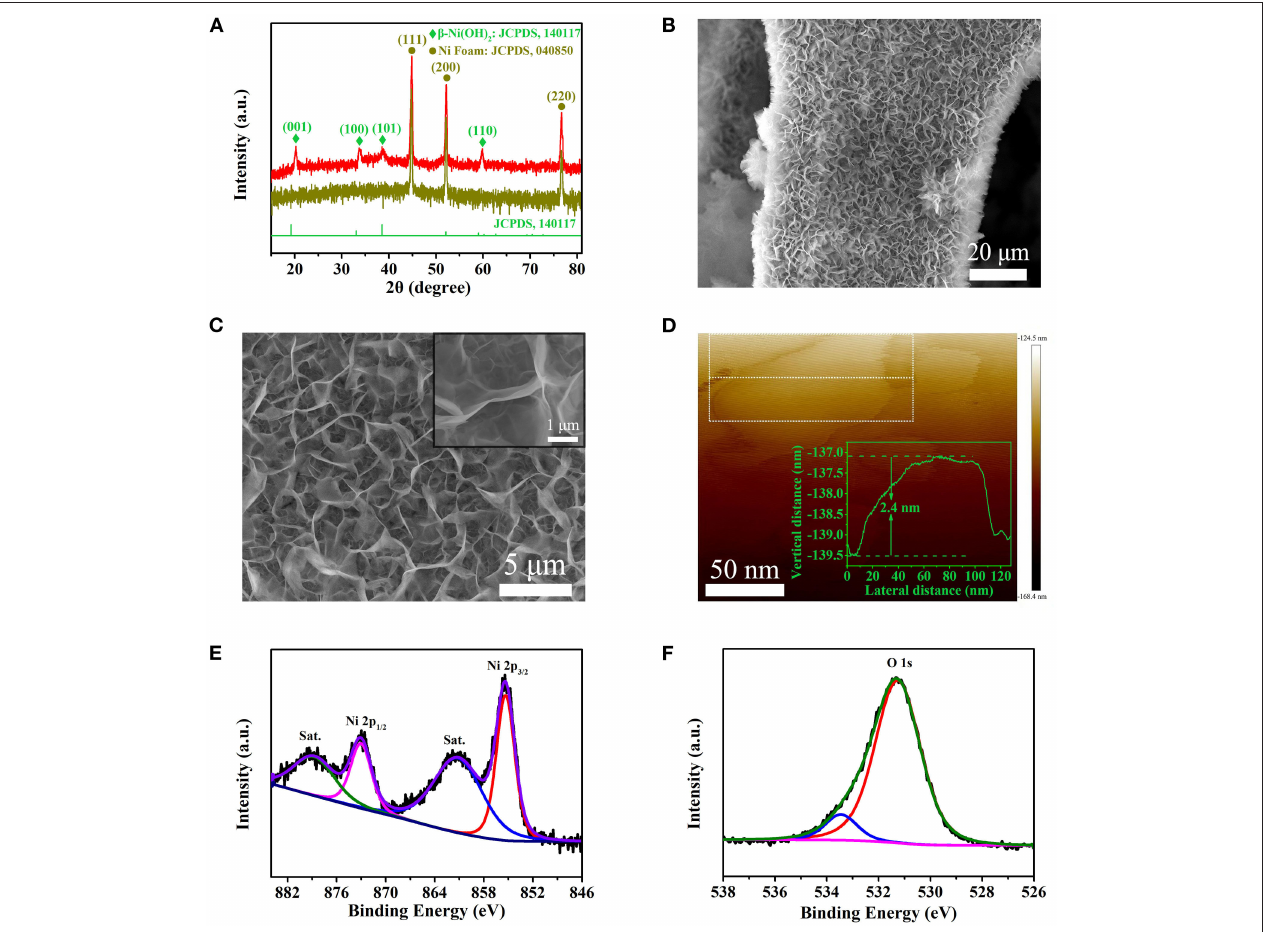
Supplementary Figure 2 shows the comparison of GCD curves, which also demonstrates that the Ni foam has a tiny